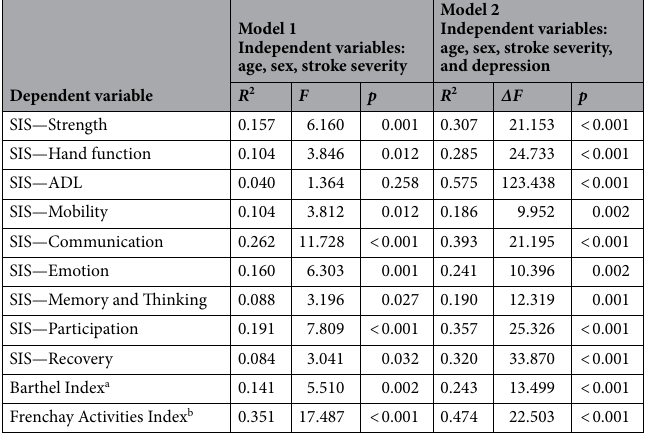
Table 3. The contribution of depression symptoms on perceived impact of stroke (each domain of Stroke Impact Scale; SIS), ADL (Barthel Index) and participation in social and everyday activities (Frenchay Activities Index) (n = 103). a n = 105. b n =